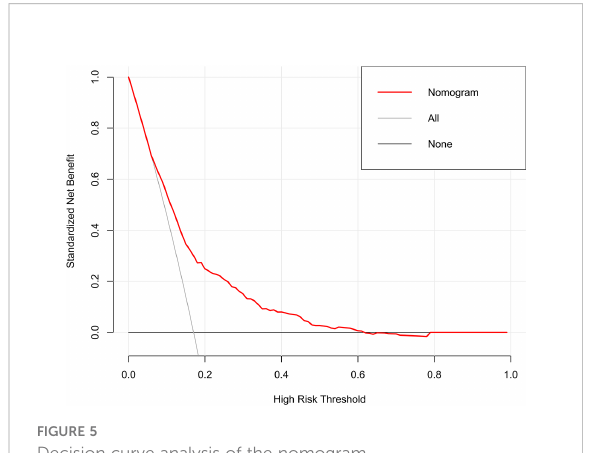
FIGURE 5 Decision curve analysis of the nomogram.